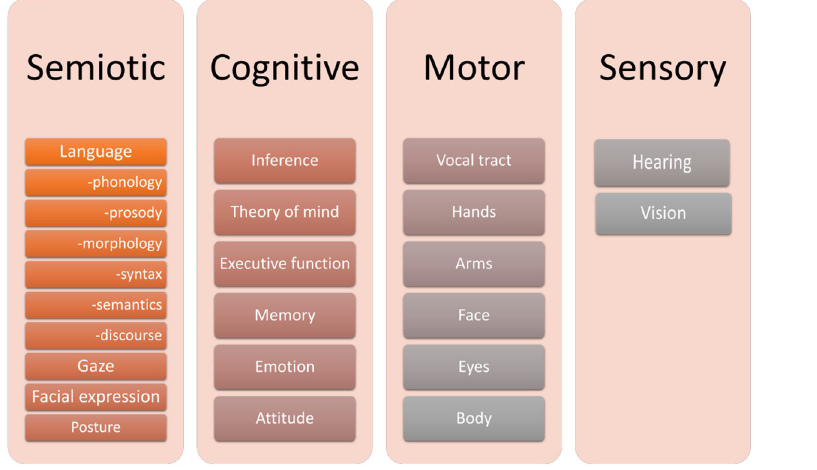
Fig 1. Elements of pragmatics (adapted from Perkins [4]).